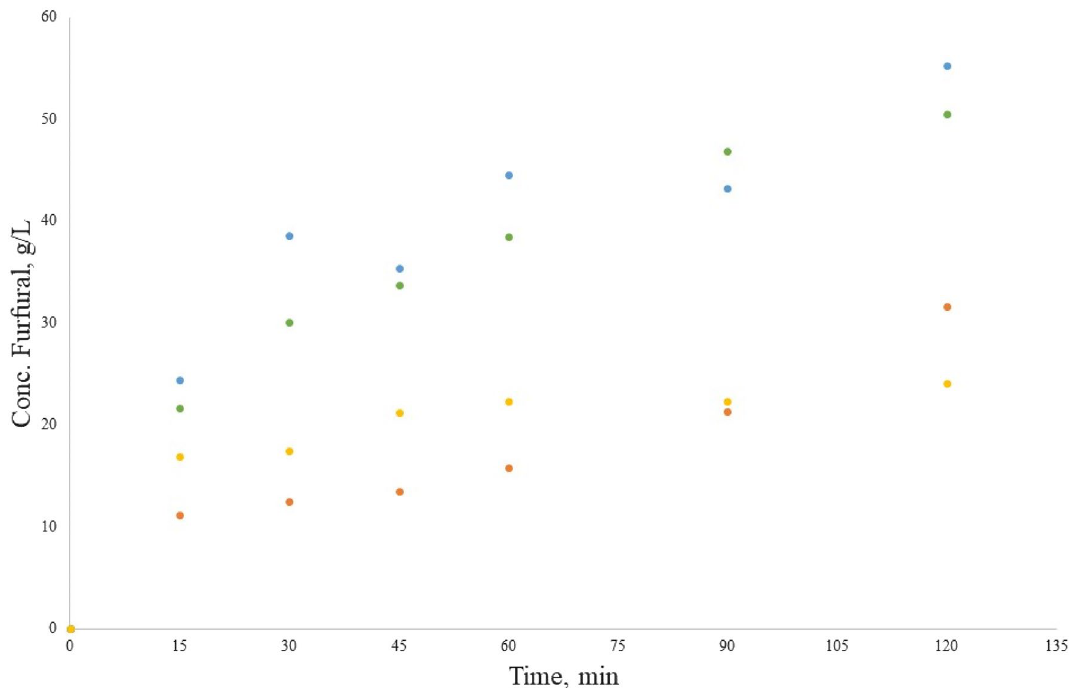
Figure 4. Furfural production in the hydrolysis reaction with CaCl 2 , from orange pectin (blue circle), tangerine pectin (green circle), mango pectin (orange circle) and tamarind pectin (light orange